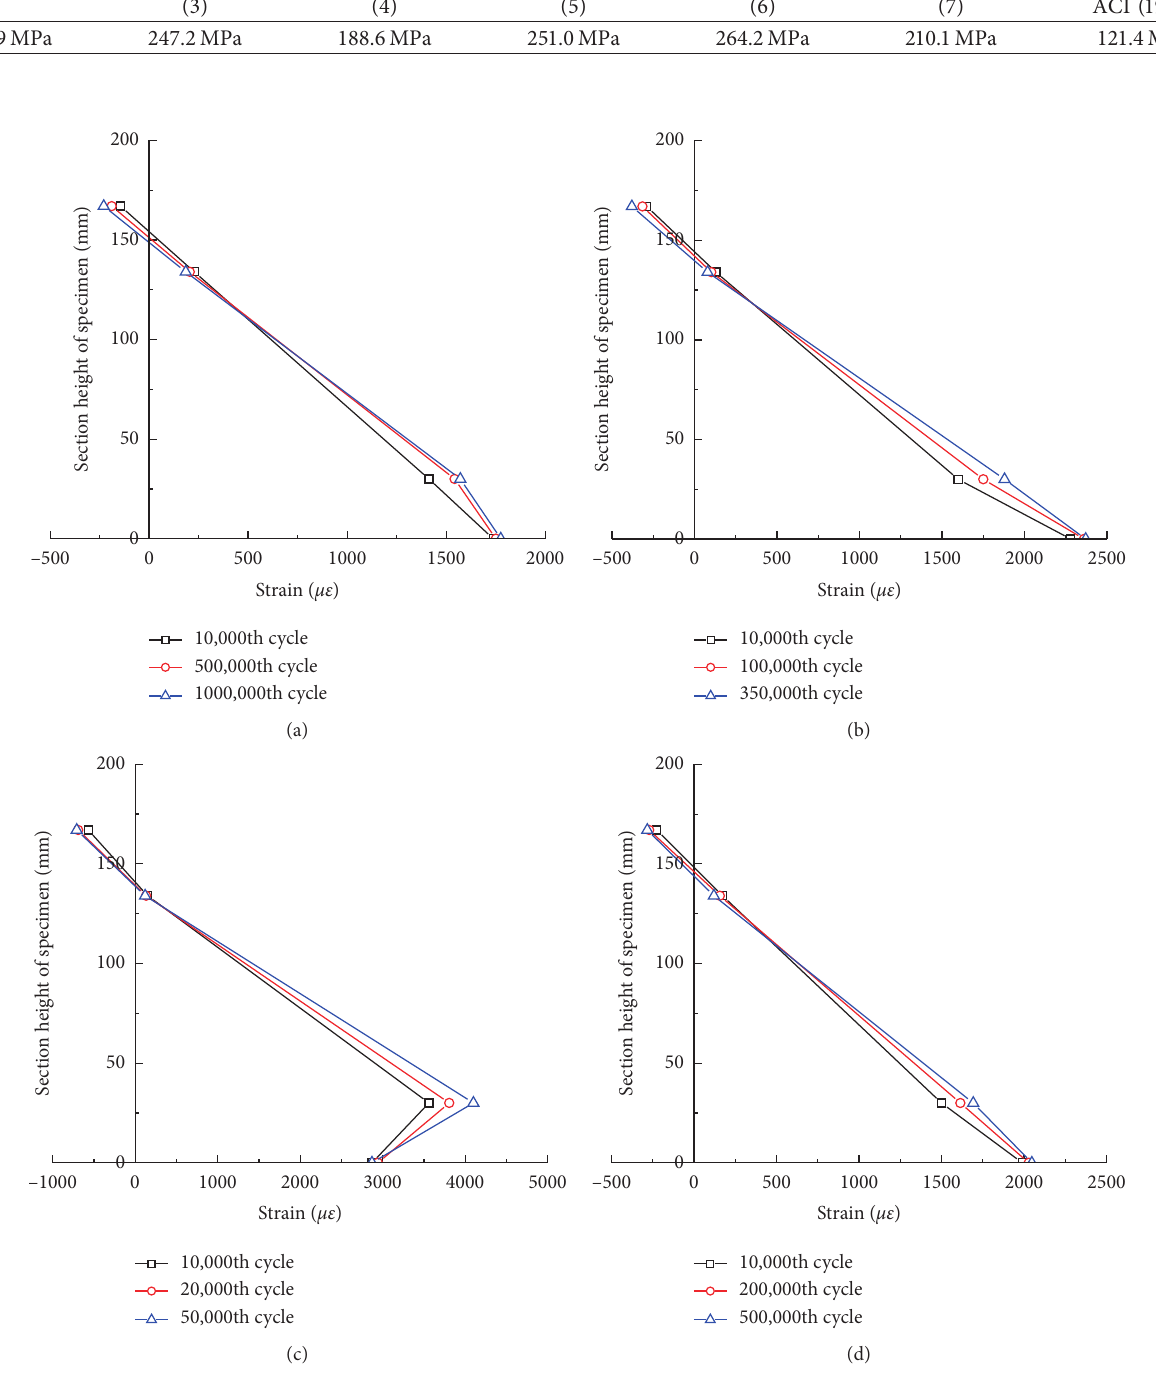
Figure 11: Strain distribution of specimens along the height of control section. (a) Specimen JB-3. (b) Specimen JB-4. (c) Specimen JB-5. (d) Specimen